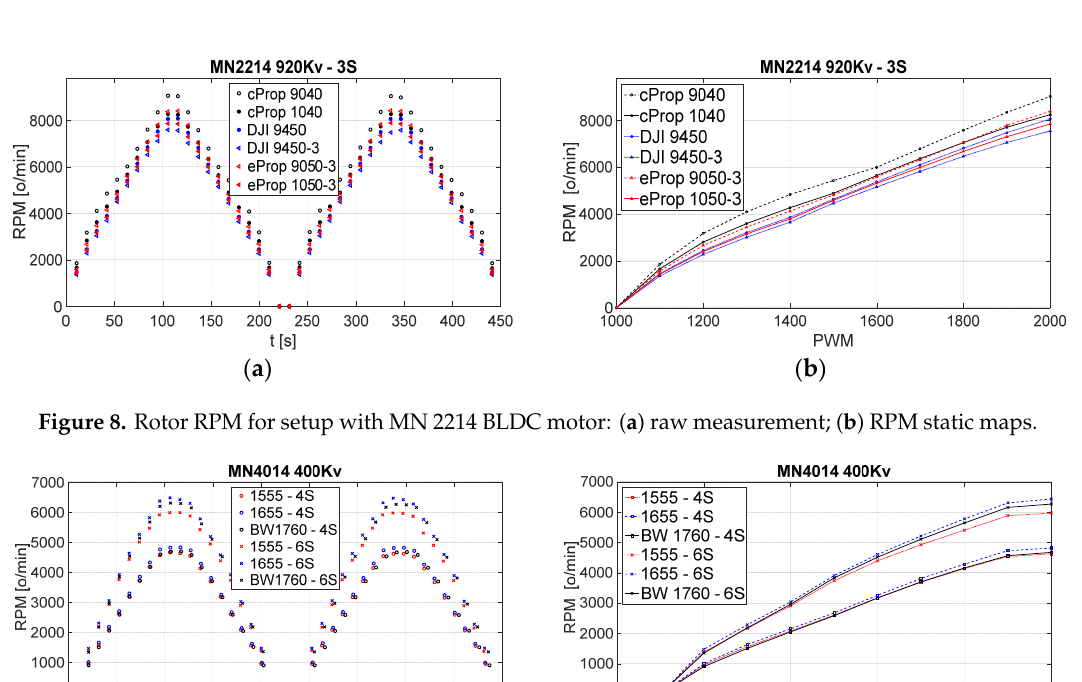
Figure 7. Rotor RPM for setup with 1806 series of BLDC motor: ( a ) raw measurement; ( b ) RPM static maps.